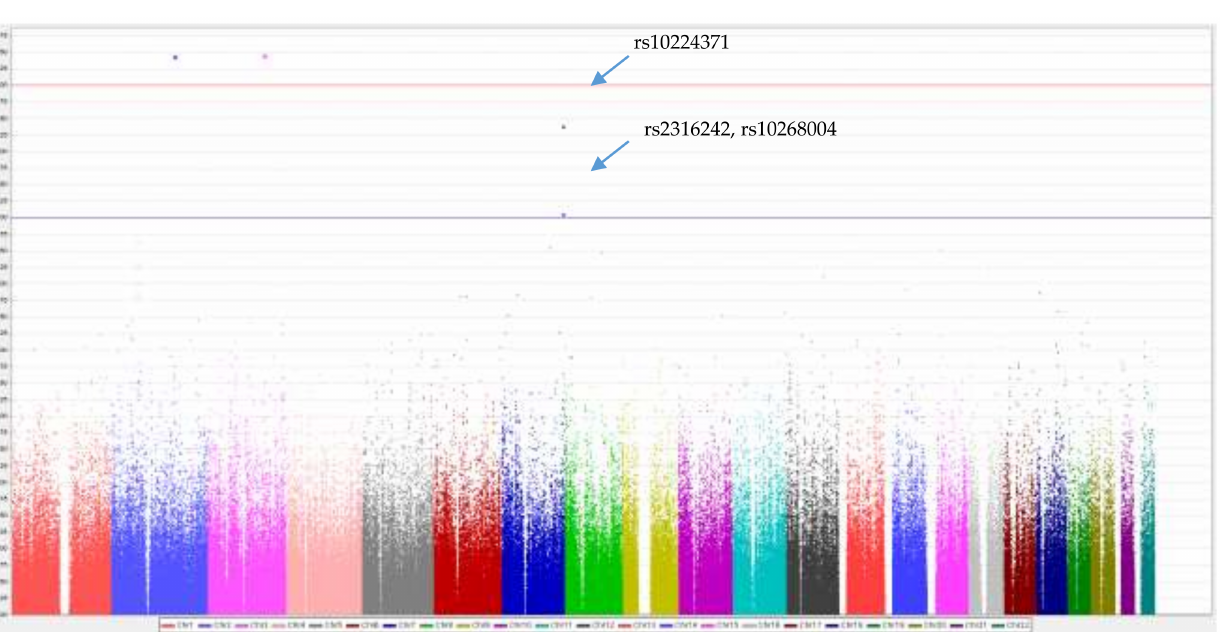
Figure 4. Manhattan plot for plasma aluminum after controlling for gender, age, smoking, and alcohol consumption. The vertical axis was − log 10 ( p -value) according to the strength of association. The horizontal axis represents chromosome location according to the genomic location. The red line represents significant levels ( p -value < 8 × 10 − 8 ). The blue line represents suggestive levels ( p -value < 1 × 10 − 6